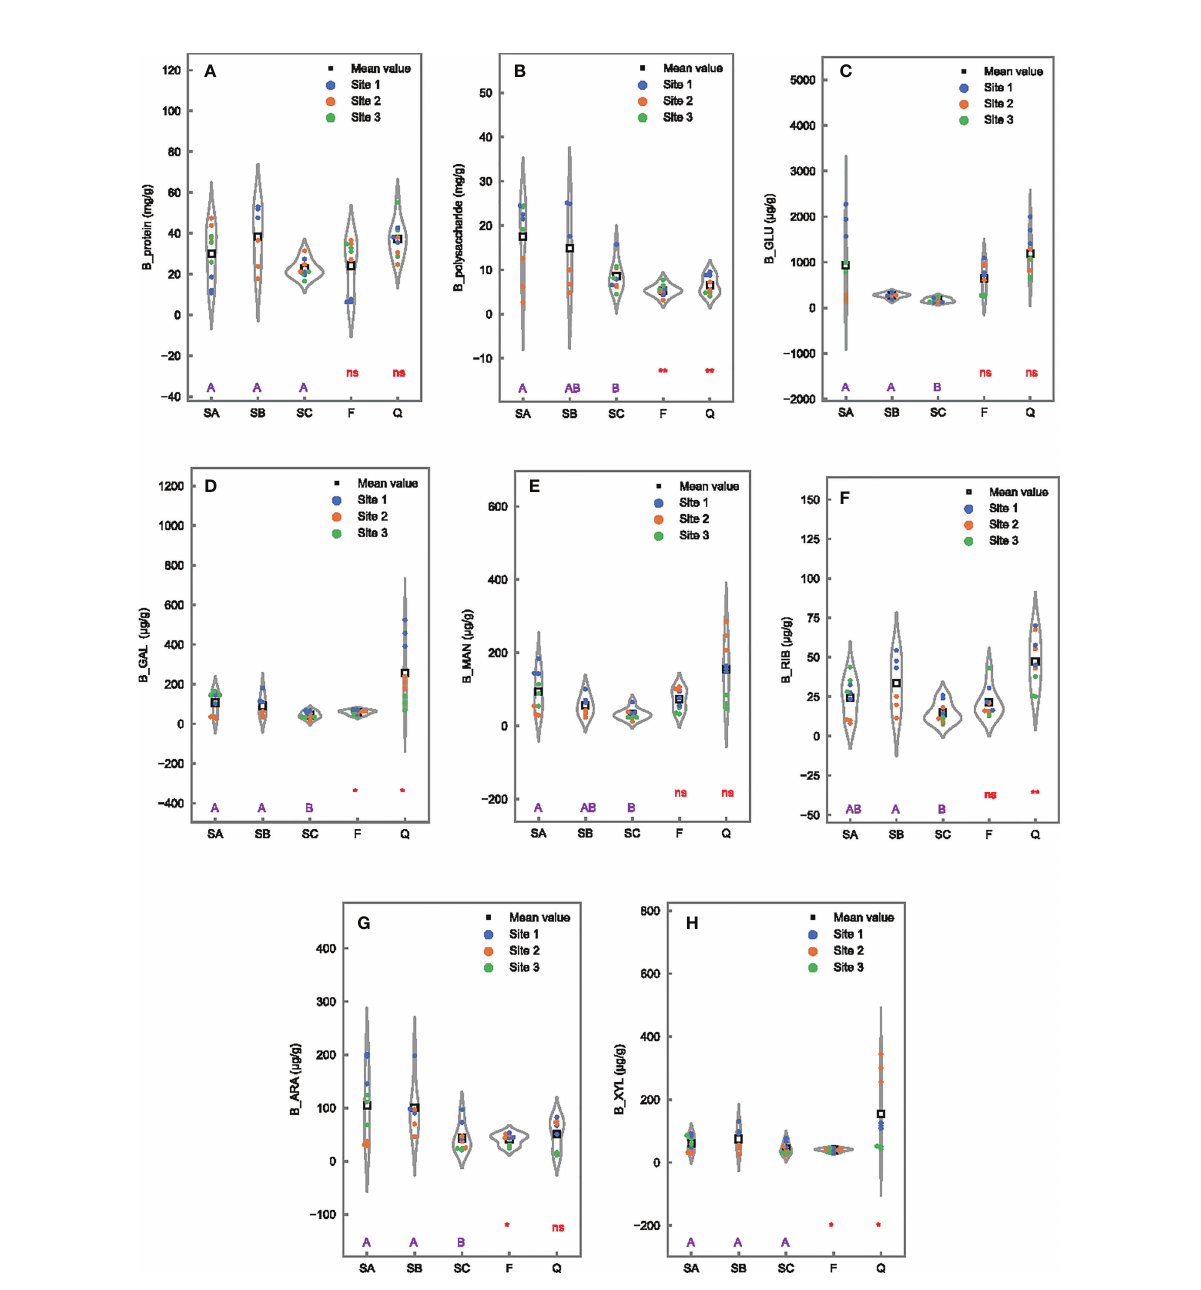
FIGURE 4 Differences of EPS constituents in bound fraction in 0- to 1-cm surface sediments among tidal levels in Futian (SA, SB, and SC), between sampling times (SA vs. F), and between Futian and Qi ’ ao wetlands (SA vs. Q). Different letter shows signi fi cant differences among tidal levels at p < 0.05 according to one-way ANOVA, while * and ** indicate signi fi cant differences between times, as well as between mangrove wetlands, at p < 0.05 and 0.01, respectively, ns indicates not signi fi cant difference, according to Student ’ s t-test: (A) B_protein; (B) B_polysaccharide; (C) B_GLU; (D) B_GAL; (E) B_MAN; (F) B_RIB; (G) B_ARA; and (H)